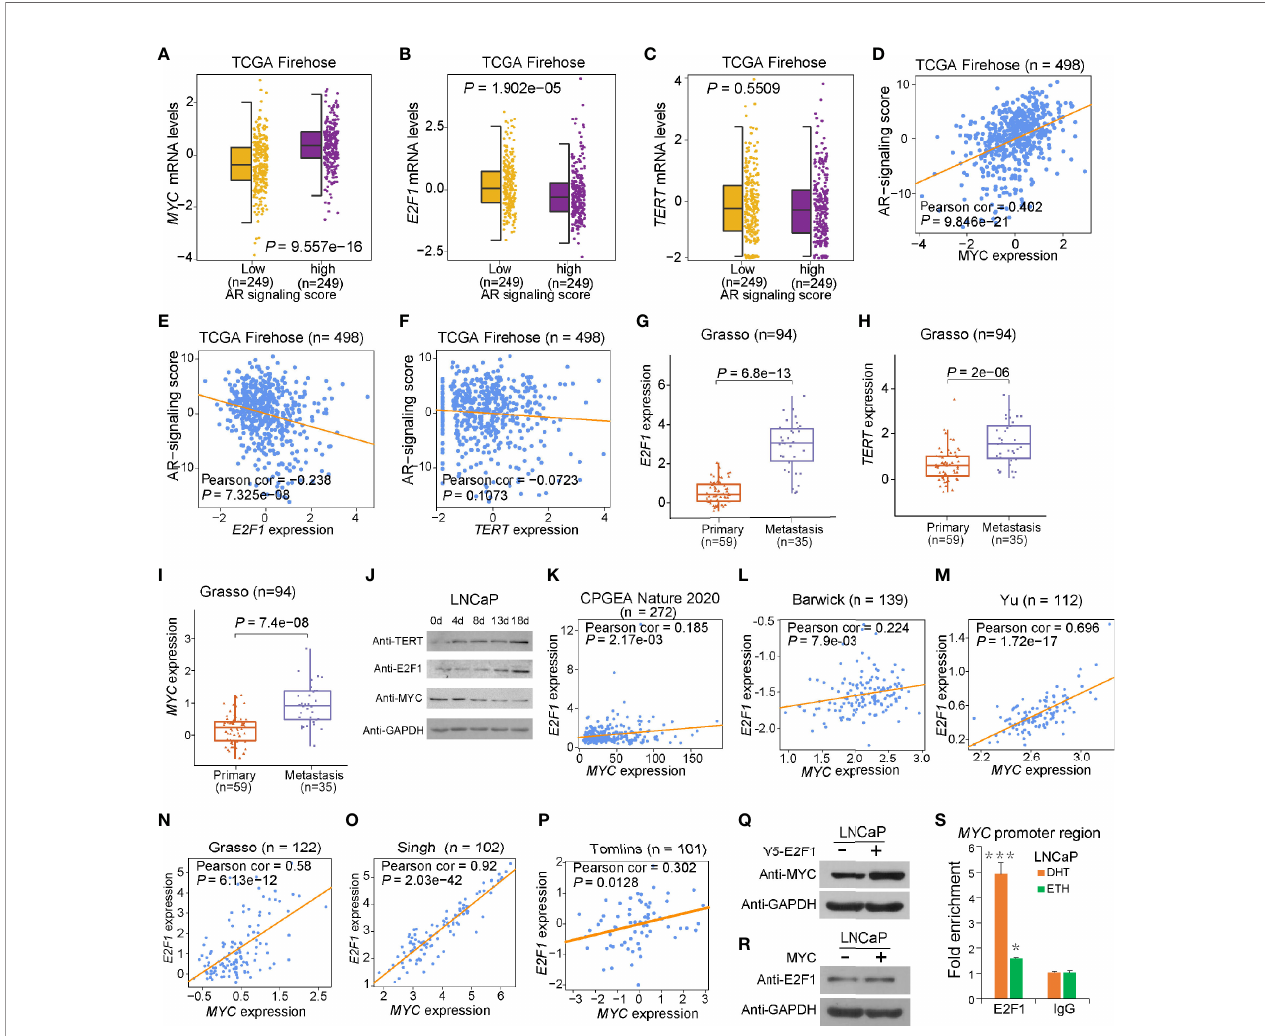
FIGURE 2 | Effect of AR singling on E2F1 , MYC , and TERT expression. (A , D) MYC was upregulated in the group with high AR signaling signature score ( SOX9 , RAN , TNK2 , EP300 , PXN , NCOA2 , AR , NRIP1 , NCOR1 , and NCOR2 ). MYC was signi fi cantly positively correlated with AR signaling score. (B , E) E2F1 was downregulated in AR signaling high group compared to AR signaling low group. E2F1 was negatively correlated with AR signaling score. (C, F) No signi fi cant correlation was observed for TERT upon the AR signaling signature in the TCGA cohort. The Z score sum of the ten-gene AR signaling signature was strati fi ed based on the median score. p- values were calculated using Mann – Whitney U test. (G – I) mRNA levels of E2F1 (G) , TERT (H) , and MYC (I) were elevated in human benign, primary, and metastasis PCa in the Grasso cohort. p- values were calculated using Kruskal – Wallis test. (J) Western blot showing protein levels of TERT, E2F1, and MYC in LNCaP cells with hormone-deprived medium for the indicated days. GAPDH was used as a loading control. (K – O) Expression correlation of MYC with E2F1 in human prostate tissues. Scatter plot showing the direct correlation between MYC with E2F1 expression in the CPGEA cohort ( n = 272) (K) , Barwick cohort ( n = 139) (L) , Yu cohort ( n = 112) (M) , Grasso cohort ( n = 122) (N) Singh cohort ( n =102) (O) , and Tomlins ( n = 101) (P) . (Q, R) Western blot showing the protein level of MYC in LNCaP cells overexpressing V5 tagged E2F1 (P) and E2F1 expression level in LNCaP cells overexpressing MYC plasmid (Q) . GAPDH was used as a loading control. (S) ChIP-qPCR results showed E2F1 chromatin binding at MYC promoter region in LNCaP cells. Error bars, s.e.m. n = 3 technical replicates. * P < 0.05, *** P < 0.001, The P values were assessed using two-tailed Student ’ s t